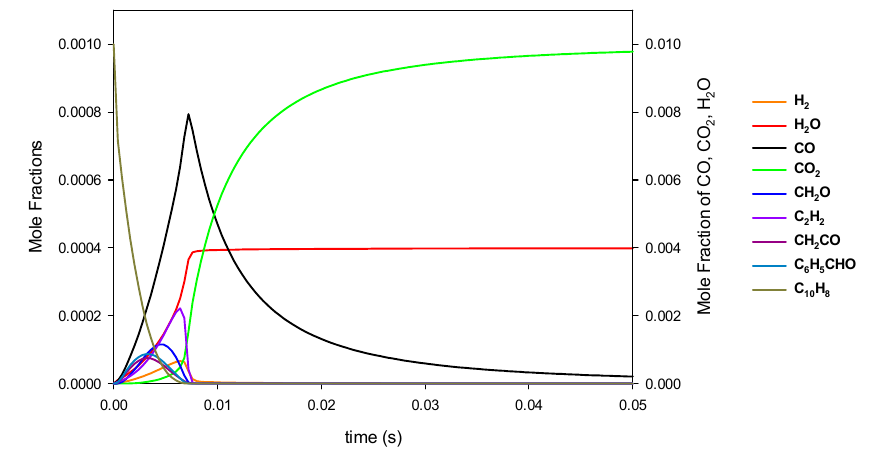
Figure 8. Combustion of 0.1% naphthalene at 1200K with 20% oxygen.